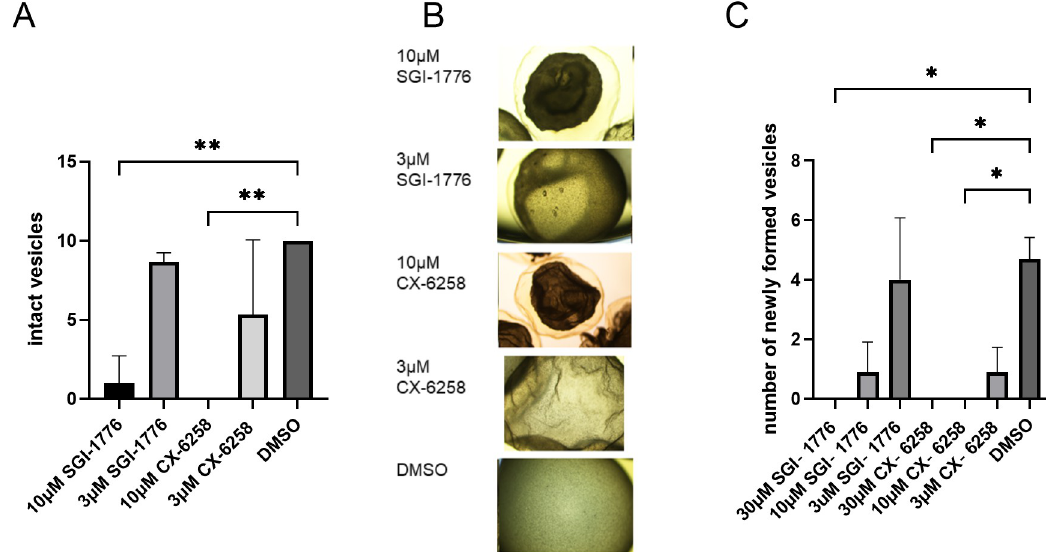
Fig 6. Effects of SGI-1776 and CX-6258 on MV and PC. (A) Inhibitor effects on mature MV. E . multilocularis MV were incubated for 28 d in the presence of different inhibitor concentrations as indicated below (with medium and inhibitor replacement every 3–4 d), and the number of structurally intact MV was inspected microscopically. One way ANOVA followed by Dunnet’s multiple comparison test was used for comparison to the control DMSO group. �� indicates p � 0.0021. (B) Representative examples of MV incubated with different concentrations of inhibitors as indicated to the left. (C) Inhibitor effectos on the formation of MV from PC. Parasite stem cell cultures were incubated for 21 d in the presence of different inhibitor concentrations as indicated below. Numbers of fully mature MV were subsequently counted. Error bars represent standard deviation. Kruskal- Wallis test followed by Dunn’s multiple comparison test was used for comparisons with control (DMSO) group. � represents p �